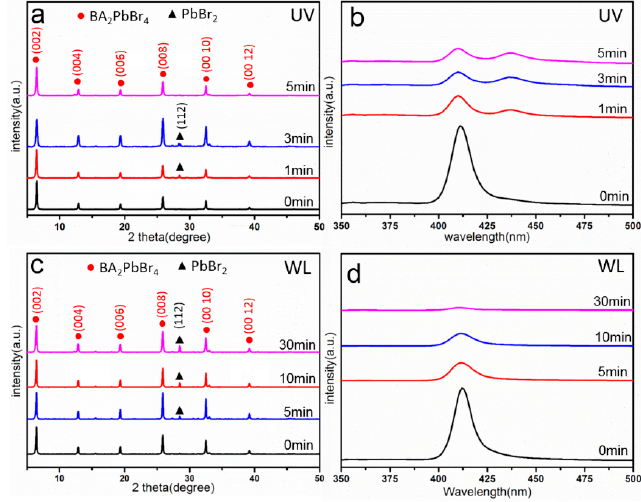
Figure 2. ( a , b ) XRD and PL spectra of BA 2 PbBr 4 nanosheets after UV irradiation for 0, 1, 3, and 5 min. ( c , d ) XRD and PL spectra of BA 2 PbBr 4 nanosheets after white light irradiation for 0, 5, 10 and 30 min.